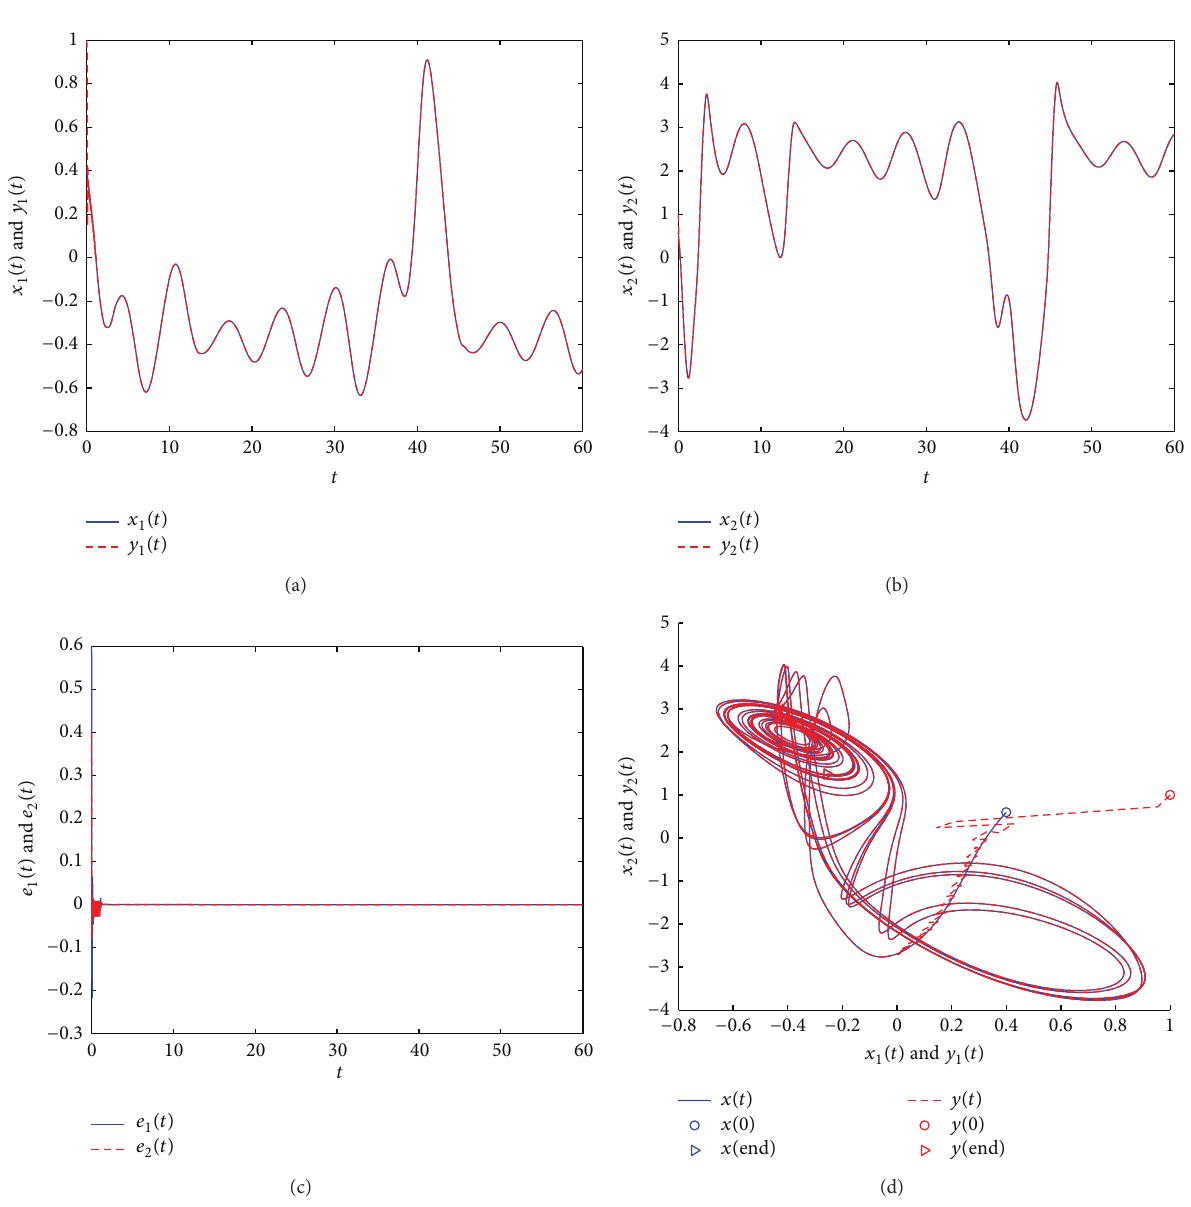
Figure 2: Time response of state variables, the synchronization errors, and the phase plots of the drive system and response system in Example 12 under the impulsive controller (0.06𝑘, −1.3𝐼)